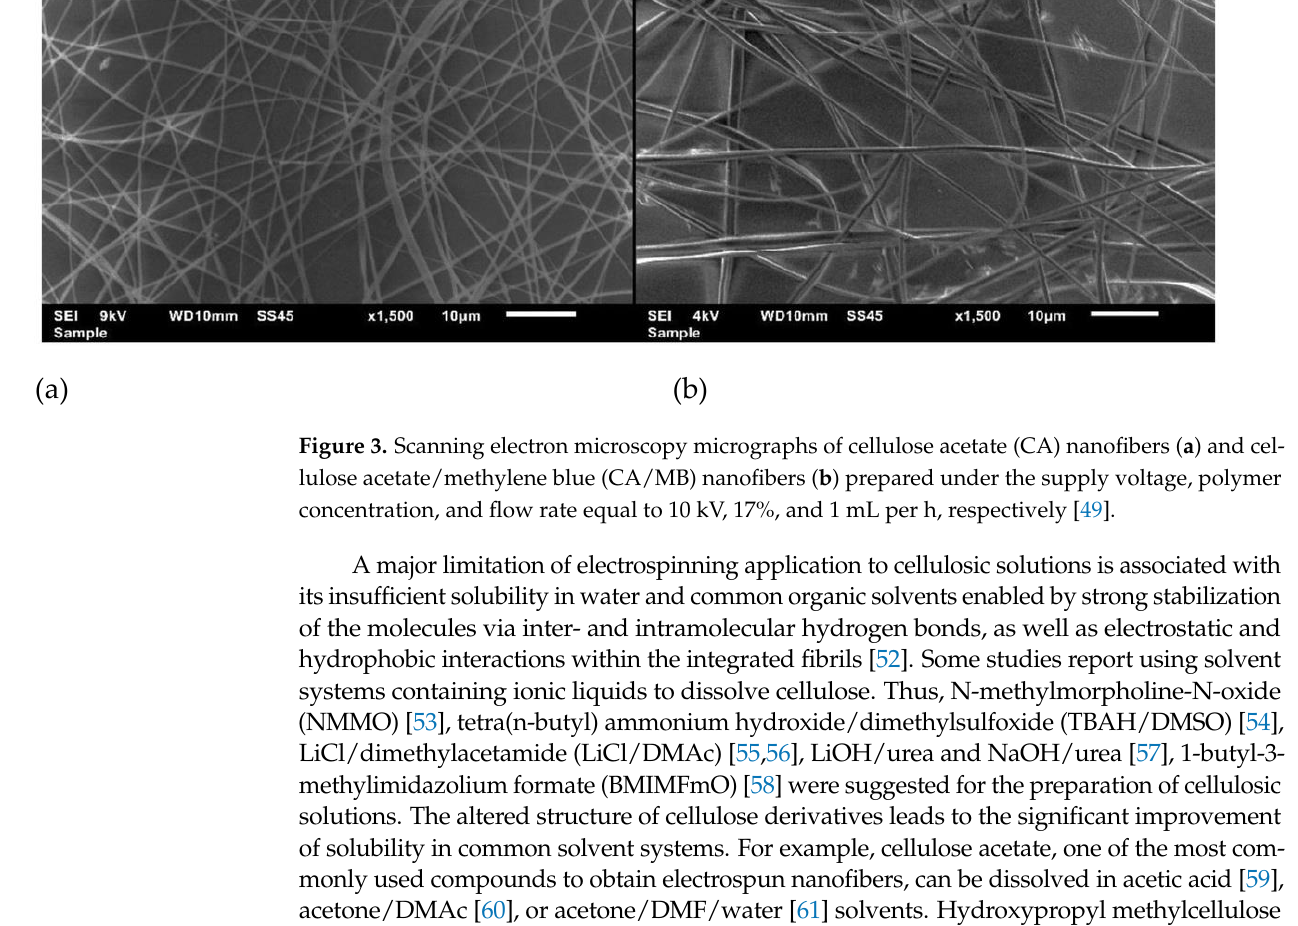
Figure 2. Schematic view of the electrospinning setup for the production of electrospun nanofibers [47].